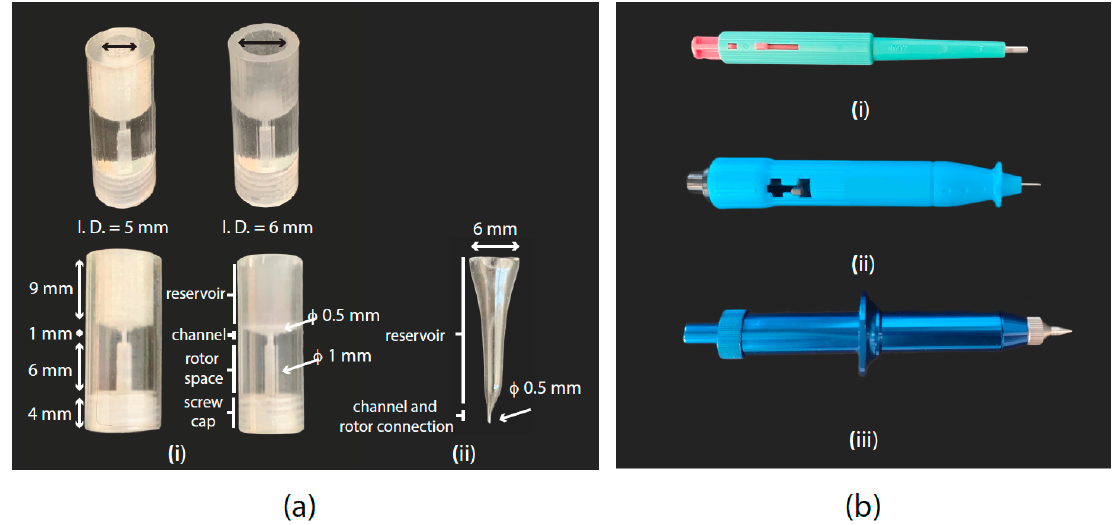
Figure 2. ( a ) (i) 3D-printed funnel. It consists of a bulk polymeric funnel, which leaves a space for the µ -rotor, and a µ -channel connecting the rotor volume with the sample reservoir. After printing, the funnel should be submitted to a coating process with deposited poly(p-xylylene) (i.e., parylene), which adds a layer of 0.5 µ m and generates a biocompatible and smoother surface. (ii) Custom-made glass funnel. It connects the funnel reservoir with the µ -rotor through a short channel. Suggested convenient dimensions are shown in the picture for both types of funnel. ( b ) Di ff erent biopsy punch models. (i) 2 mm biopsy punch used for sample collection and filling process inside the standard HR-MAS